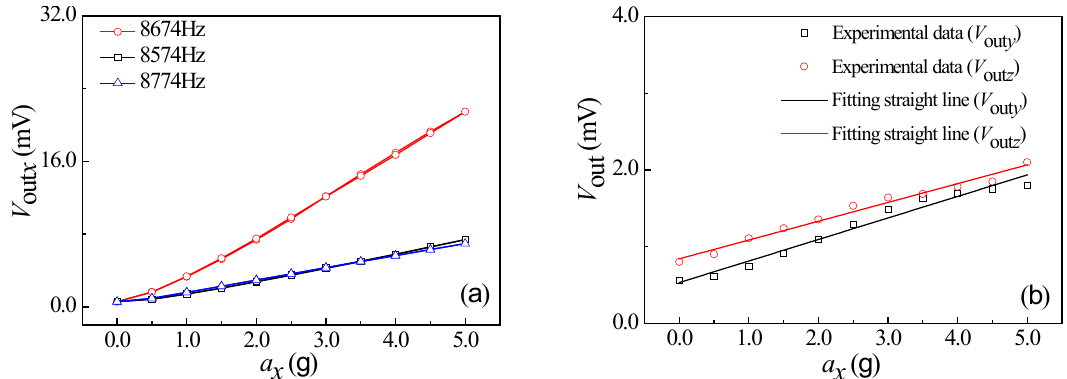
Figure 9. The relationship curves of output voltage and a x . ( a ) The characteristic curves of differential frequency variation. ( b ) The relationship curves between V out along nonsensitive axis and a x . lower than that between x -axis and y -axis.